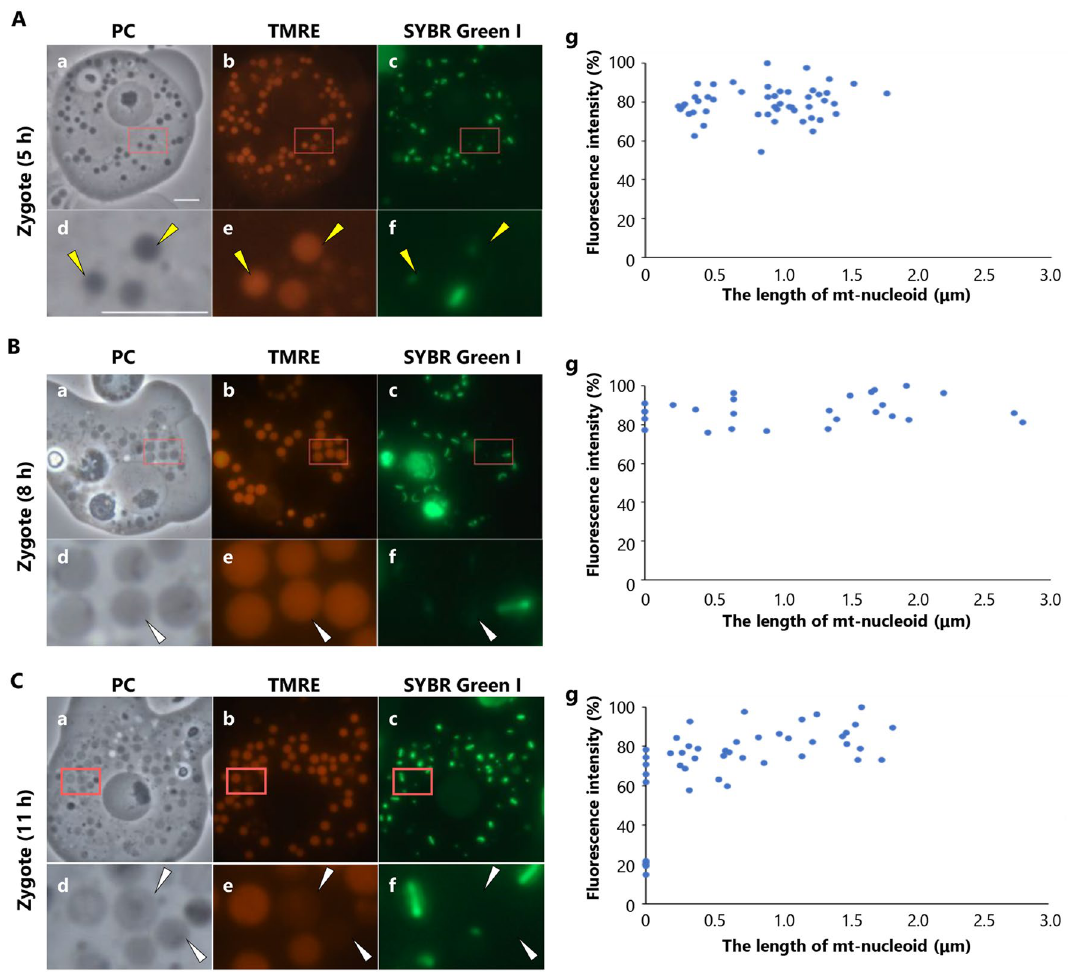
Figure 2. Monitoring mitochondrial membrane potential during zygote maturation using TMRE staining. ( A–C ) Observations of mitochondria stained with TMRE in zygotes at 5 h, 8 h, and 11 h after plating. Both DP246 and AI35 were stained with TMRE and then crossed. Before observations, mt-nucleoids were visualized by staining with SYBR Green I ( c , f ). The area enclosed by the square in each image is magnified and shown in panels ( d – f ). In zygotes, ( A ) at 5 h after plating, mitochondria with mt-nucleoids < 0.5 μm (yellow arrow) were observed, and ( B , C ) mitochondria without mt-nucleoid (white arrow) were also observed in zygotes at 8 h and 11 h after plating. In zygotes, at 11 h after plating, several mitochondria without mt-nucleoids decreased the fluorescence of TMRE (white arrow). Phase contrast ( a , d ), TMRE ( b , e ), and SYBR Green I images ( c , f ) are presented. Scale Bar = 5 μm. ( g ) Scatter plot of fluorescence intensity vs. the length of mt-nucleoids in the mitochondria of the zygote during digestion of mt-nucleoids. The fluorescence intensity of mitochondria stained with TMRE was plotted against the length of their mt-nucleoids in zygotes at ( A ) 5 h, ( B ) 8 h, and ( C ) 11 h after plating. The brightest signal of the TMRE in each cell was set to 100%. ( A ) n = 51, ( B ) n = 29, and ( C ) n =